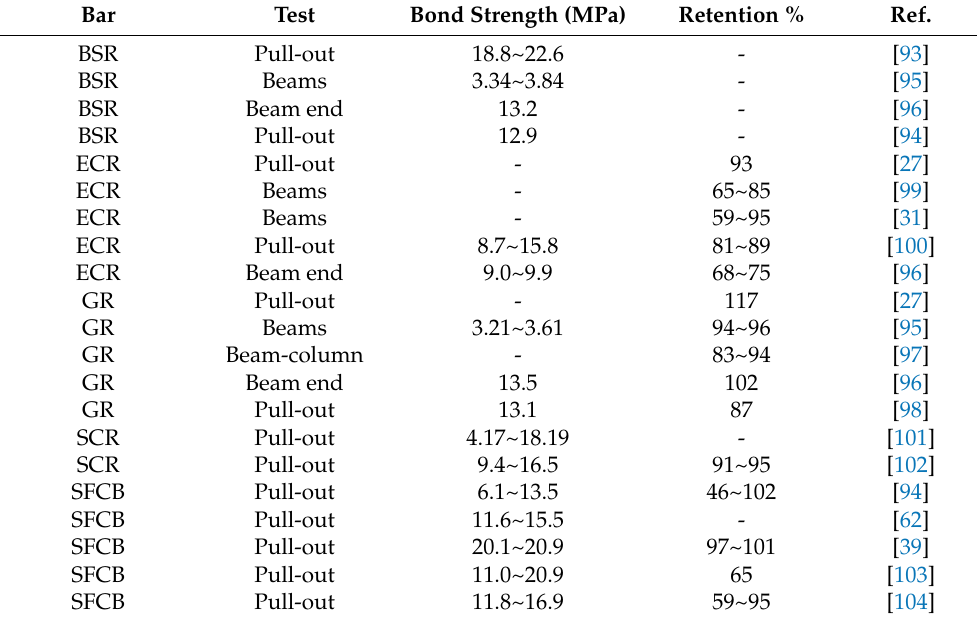
Table 4. Experiments on bond strength.